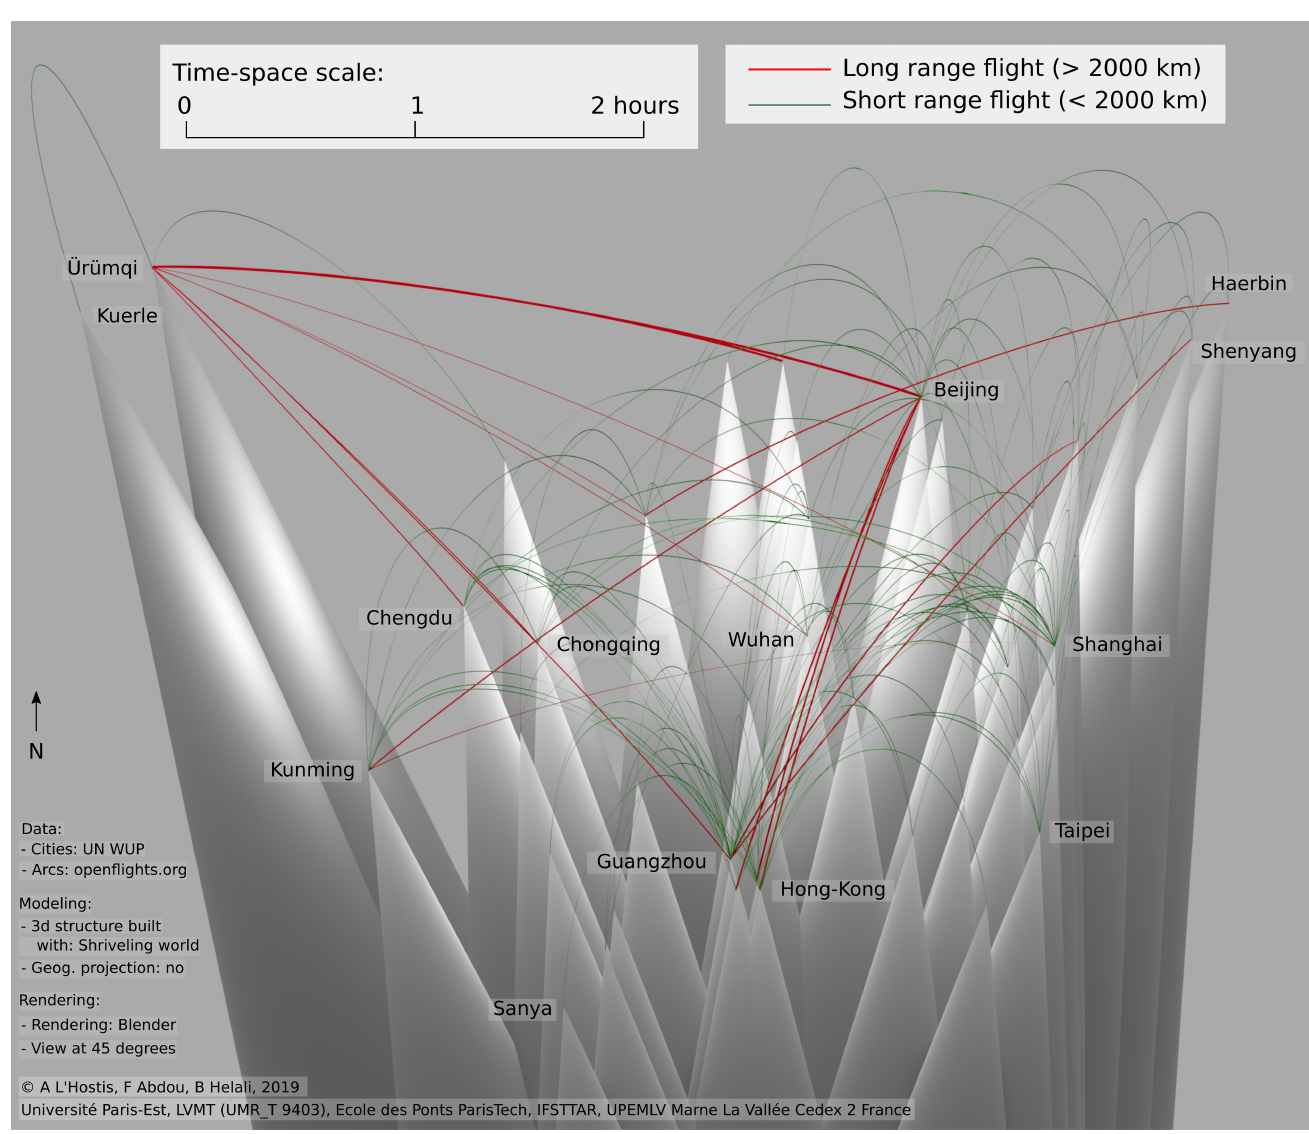
Figure 4. A representation of the Chinese geographical time-space in 2006. View of a model generated by the Shriveling world software, unprojected Chinese cities, flight information from openflights.org, UN WUP cities